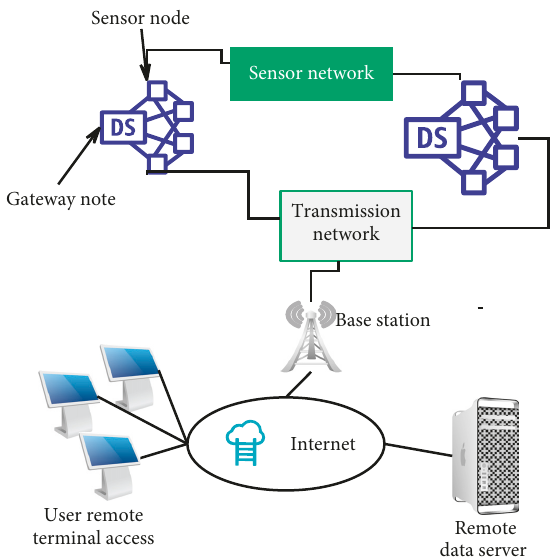
Figure 6: Sensor network system diagram of crop environmental